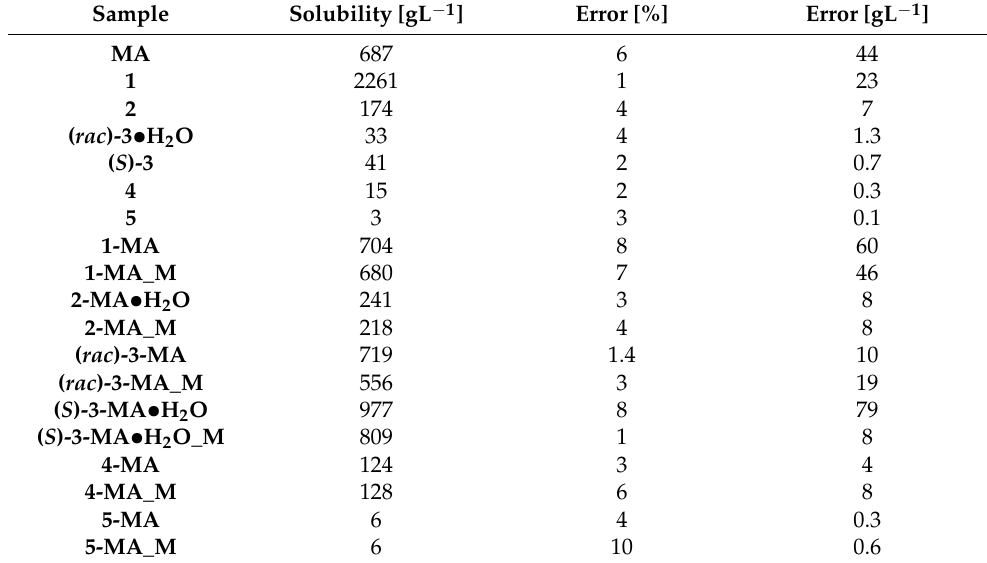
Table 3. Solubility values, error margins and decreases or increases of API solubilities in the investi- gated maleates.